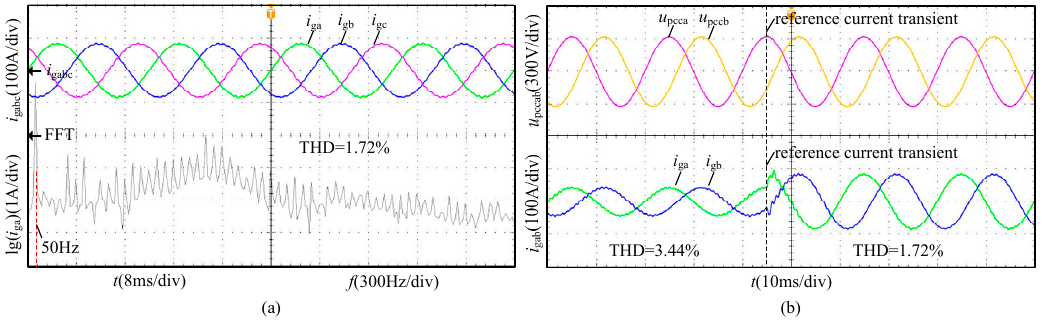
Figure 16. Experimental waveforms of u pcc and i g with proposed admittance reshaping technique 1 within the parameter design range. ( a ) Steady state; ( b ) Transient.